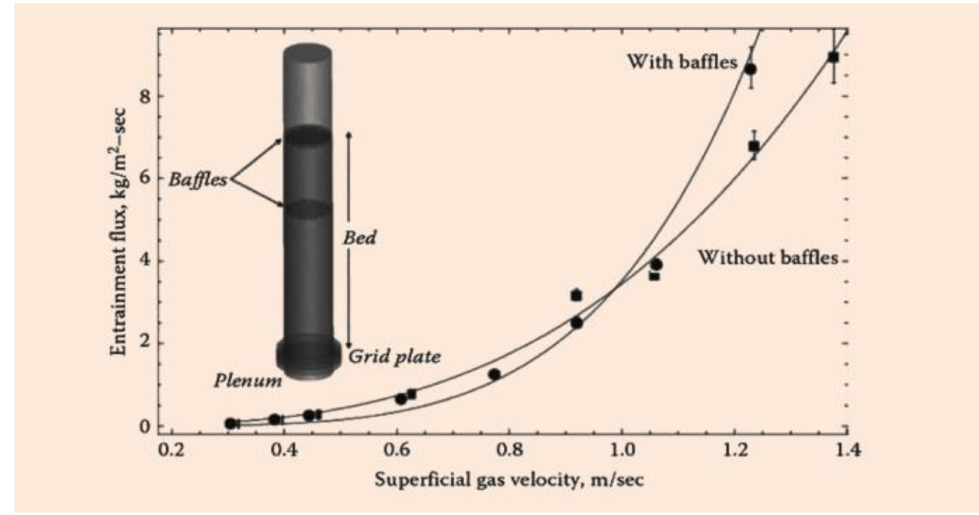
Figure 20. Influence of baffles on catalyst carry-over in the freeboard. Adopted from Cocco et al.